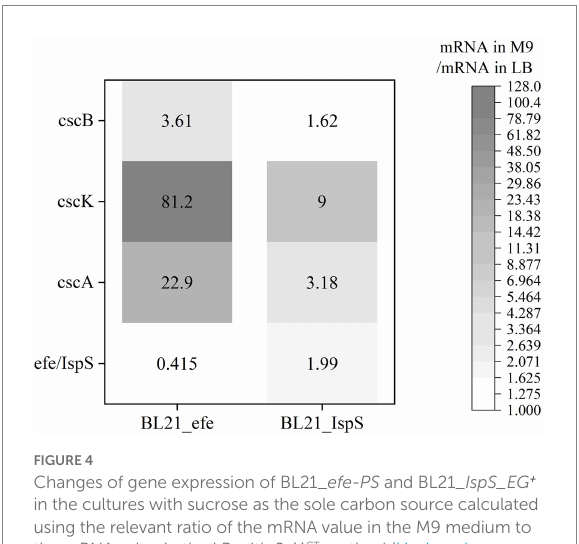
FIGURE 4 Changes of gene expression of BL21_ efe-PS and BL21_ IspS_EG + in the cultures with sucrose as the sole carbon source calculated using the relevant ratio of the mRNA value in the M9 medium to the mRNA value in the LB with 2 −ΔΔ CT method (Livak and Schmittgen, 2001).